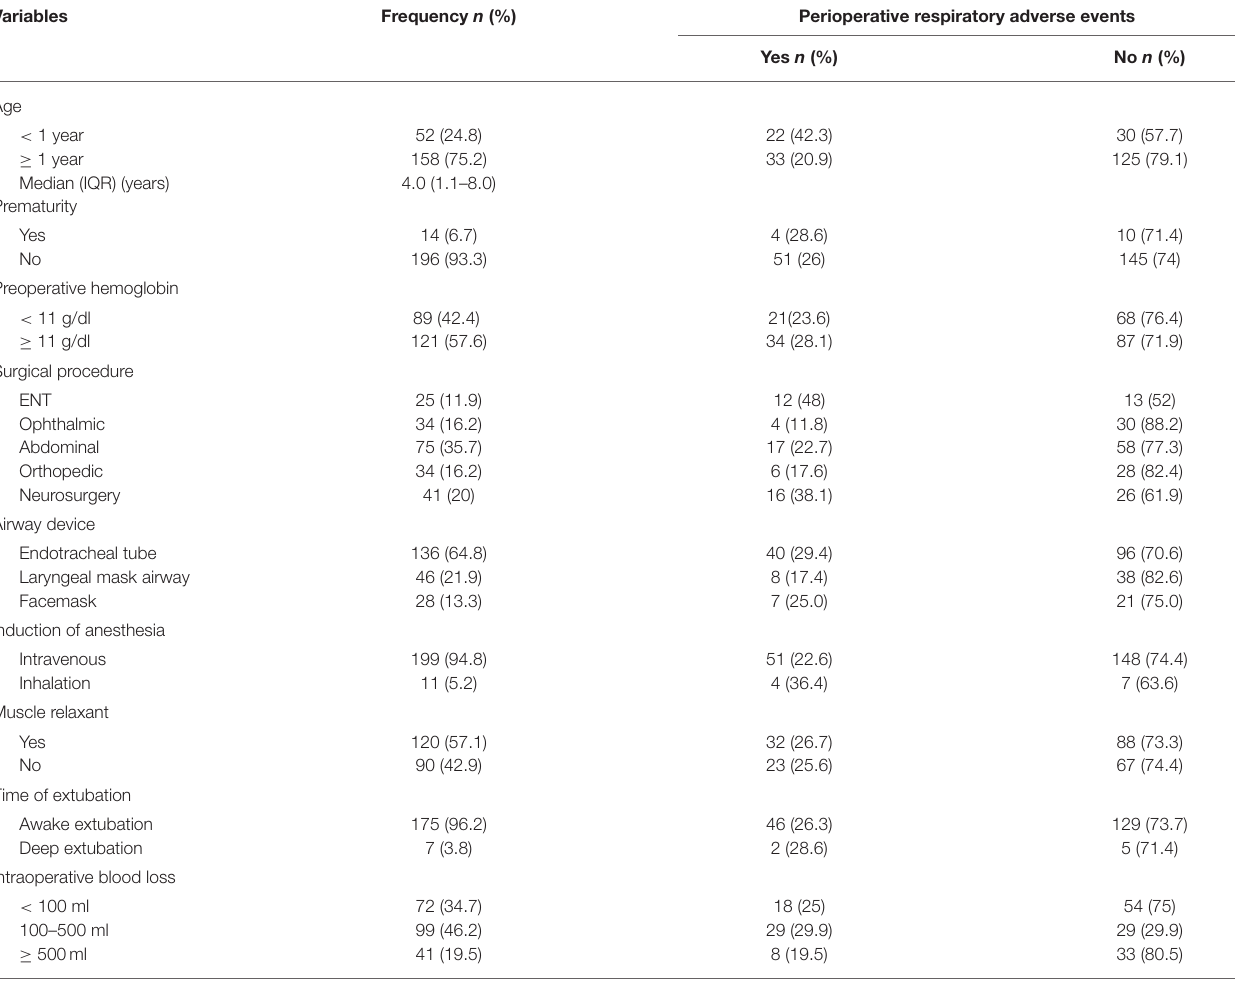
TABLE 2 | Clinical characteristics of pediatric surgical patients who underwent surgery under general anesthesia in UoGCSH and TGSH from March 1–May 30, 2020 ( N = 210).